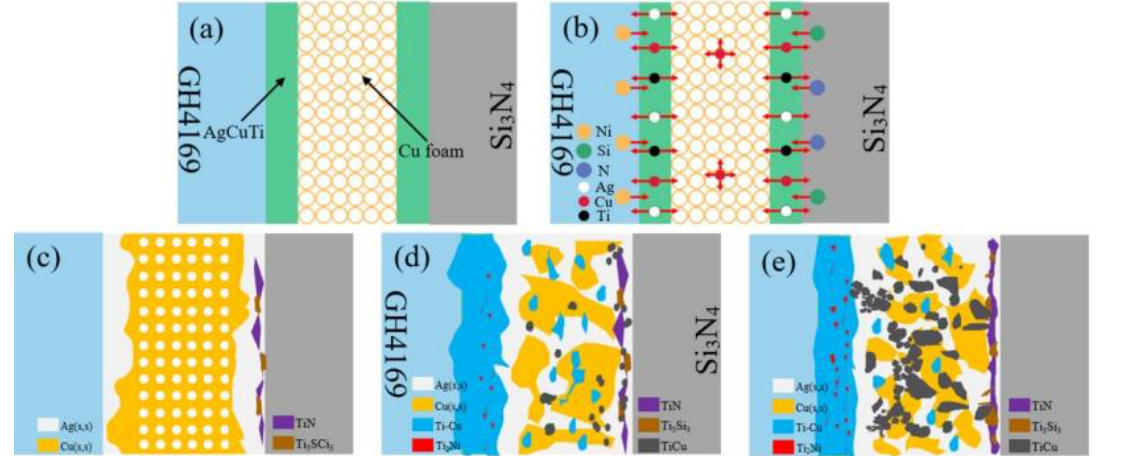
Figure 8. Schematic of the GH4169/Si 3 N 4 brazed joint formation mechanism. ( a ) Brazing interface; ( b ) filler element begins to diffuse; ( c ) Cu foam begins dissolution; ( d ) Cu foam dissolved completely; ( e ) increase in the TiCu phase.